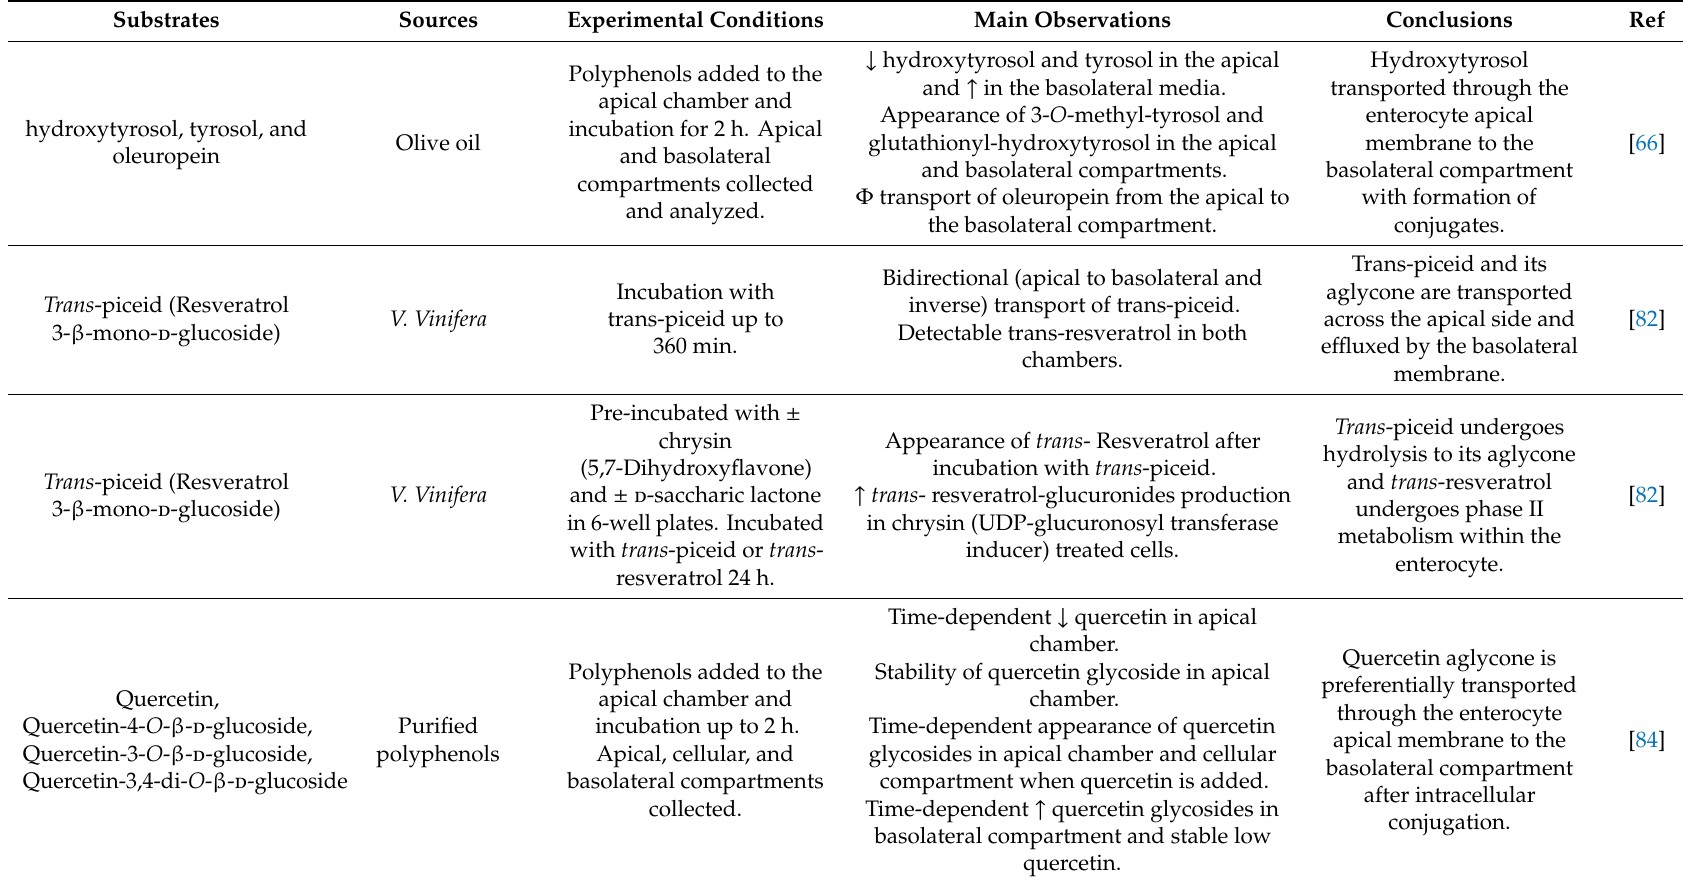
Table 2. Experimented Caco-2 cells in polyphenol transport and